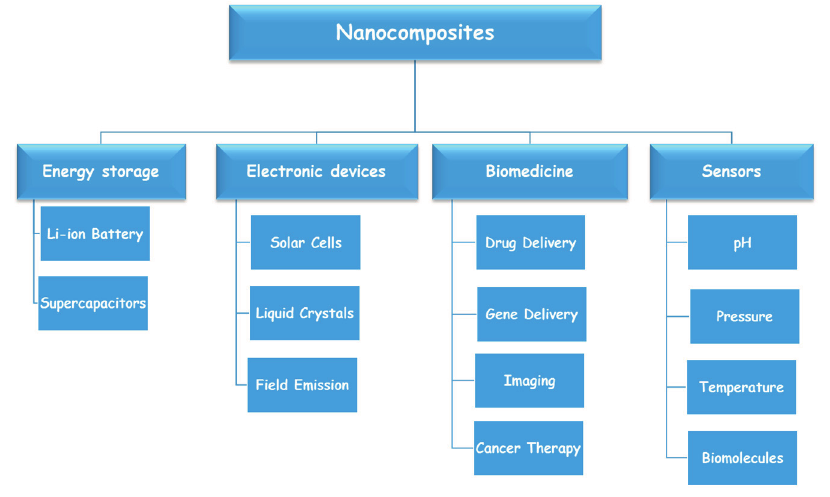
Figure 1. Technological applications of carbon